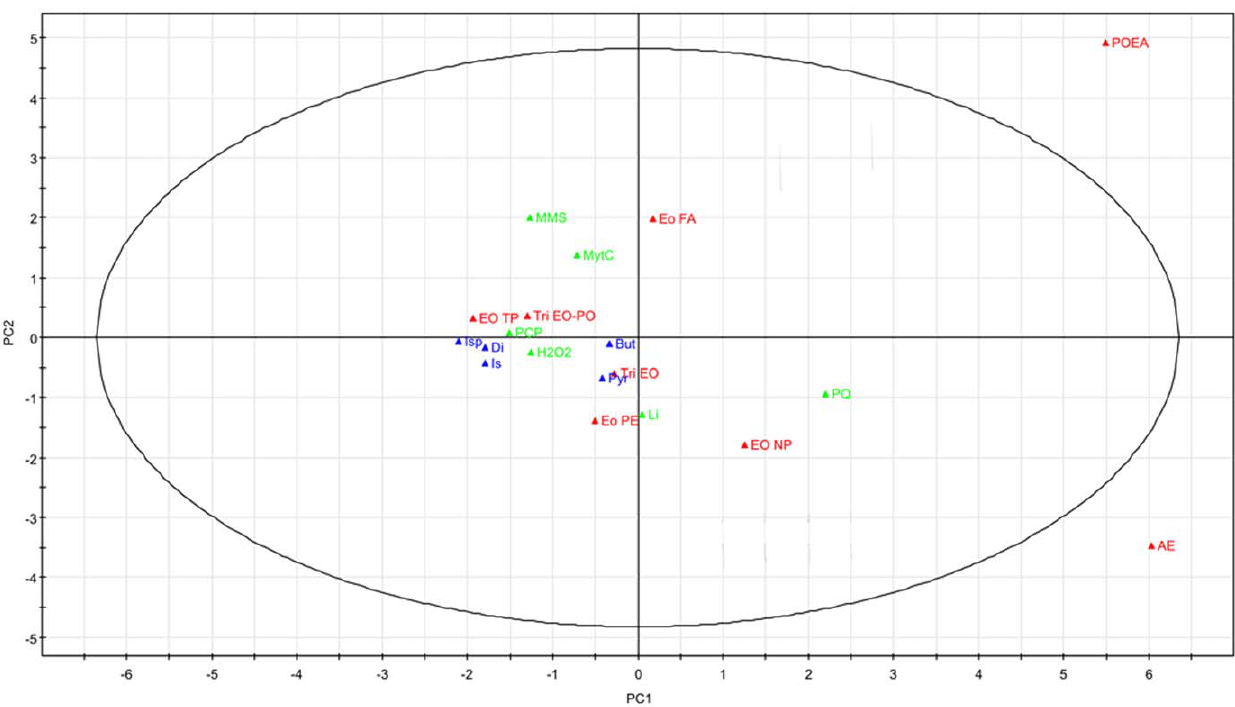
Figure 4. Principal component analysis of FIS (fold induction score) dataset. The first two components (PC1 and PC2) are shown. Individual points represent the gene expression pattern. This plot shows the possible presence of outliers, groups, similarities and other patterns in the data. Observations situated outside the ellipse are outliers. Blue dots: solvents, red dots: surfactants, green dots: reference compounds.